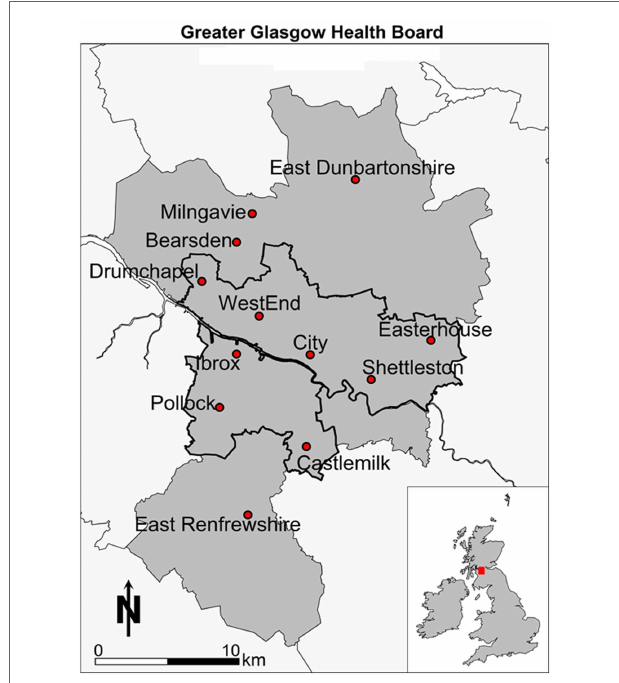
FigUre 1 | reference map